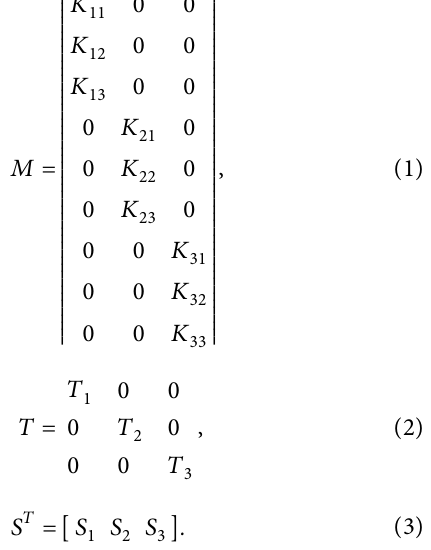
Table 2: Analyzing the results of the L 9 orthogonal array. A B C Density Relative density S. No.